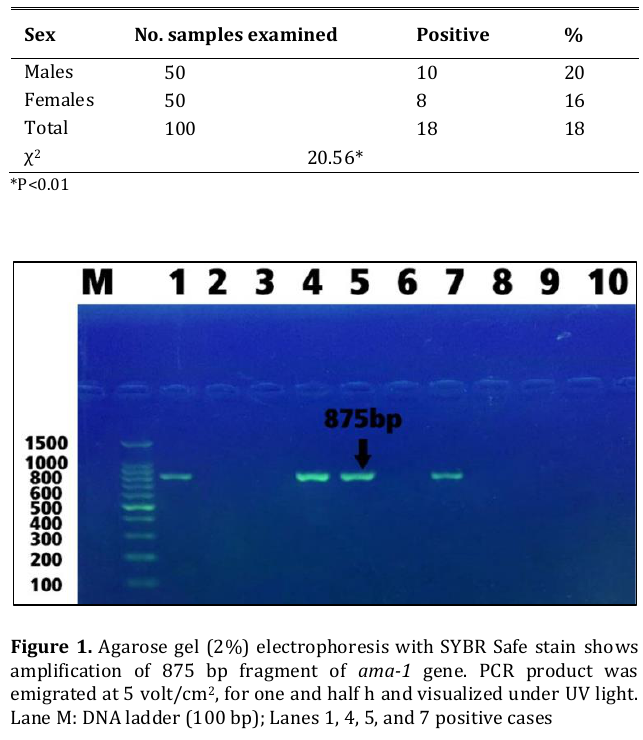
Table 2. Infection rate of Plasmodium gallinaceum